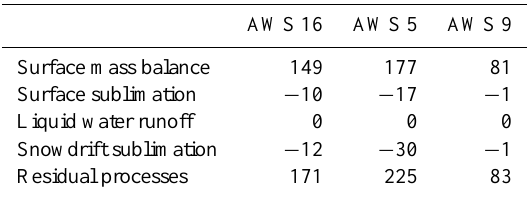
Table 4. Specific surface mass balance and its components (all unitsmmw.e.yr − 1 ) at AWS 16, 5 and 9 for 2009–2010, with inclu- sion of SU s and SU ds estimates during the two data gaps at AWS 16. These estimates are computed by linearly interpolating mean subli- mation rates in the month before and after each gap. AWS 16 AWS 5 AWS 9 Surface mass balance 149 177 81 Surface sublimation − 10 − 17 − 1 Liquid water runoff 0 0 0 Snowdrift sublimation − 12 − 30 − 1 Residual processes 171 225